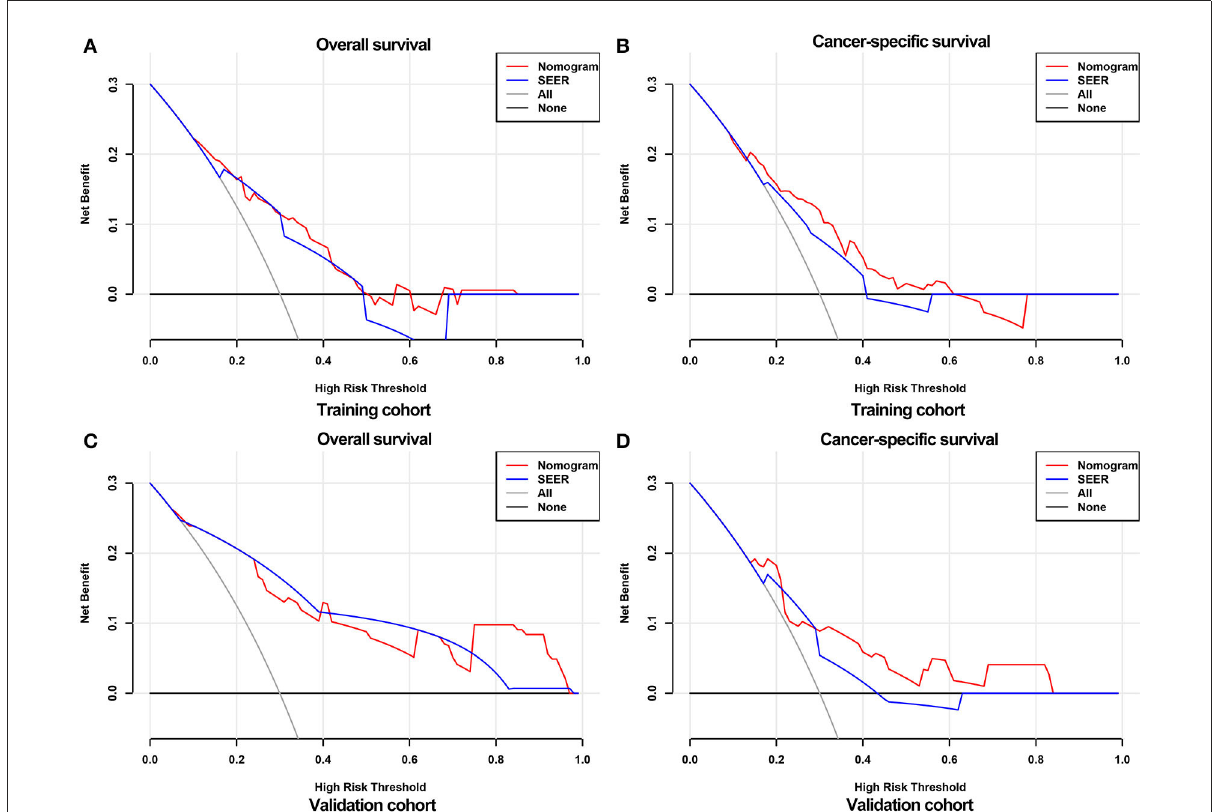
FIGURE6 DCA curves for validating the clinical utility of the nomograms. DCA curves for OS (A) and CSS (B) in the training cohort. DCA curves for OS (C) and CSS (D) in the validation